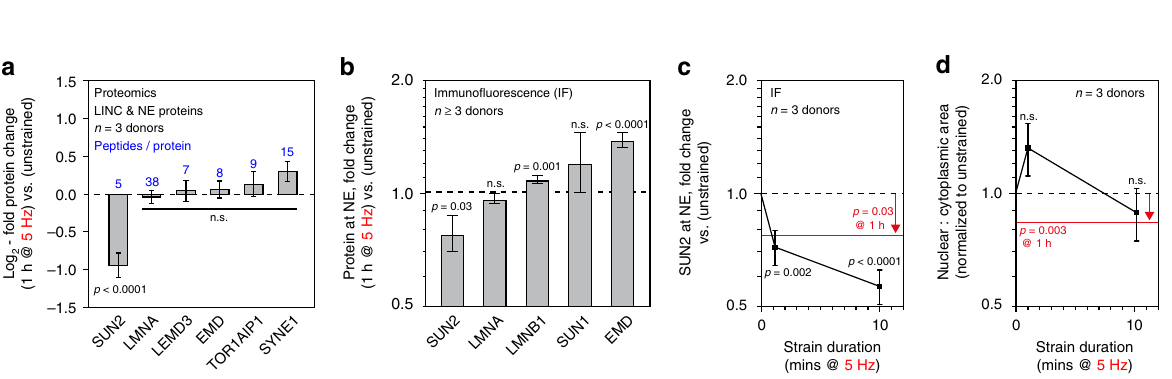
Fig. 4 CTS causes loss from the nuclear envelope (NE) and turnover of SUN2 protein. a Changes to linker of nucleoskeleton and cytoskeleton (LINC) complex and NE proteins in primary hMSCs, detected and quanti fi ed by MS immediately following CTS (1 h at 5 Hz, 2.6 – 6.2% strain; n = 3 donors), relative to unstrained controls. SUN2 was found to be signi fi cantly down-regulated, but was recovered 24 h after CTS (Supplemental Fig. 3d). Numbers in blue indicate the number of peptides detected per protein identity. p -values were calculated using empirical Bayes-modi fi ed t-tests with Benjamini – Hochberg correction. See Supplementary Data 4. b Immuno fl uorescence (IF) quanti fi cation of proteins localized at the NE immediately following CTS (1 h at 5 Hz, 2.6 – 6.2% strain; n = 3 donors for SUN1, SUN2, LMNA, and LMNB1; n = 4 donors for EMD; see Supplementary Figs. 6a – e for data distributions and donor- to-donor variation). c IF quanti fi cation of SUN2 at the NE following 1 and 10 min of CTS at 5 Hz (2.6 – 6.2% strain; n = 3 donors). Red line indicates SUN2 levels following 1 h of CTS ( p = 0.03). Signi fi cant loss of SUN2 at the NE occurred within 1 min (1 min, p = 0.002; 10 min, p < 0.0001). d Nuclear to cytoplasmic area ratios quanti fi ed following 1 and 10 min of 5 Hz CTS. Red line indicates area ratio following 1 h of CTS ( p = 0.003; Fig. 1f). These results indicate that loss of SUN2 from the NE precedes changes to cellular morphology. p -values in b – d determined from linear models (ANOVA tests). All plots show mean ± s.e.m.; see Supplementary Table 1 for sample